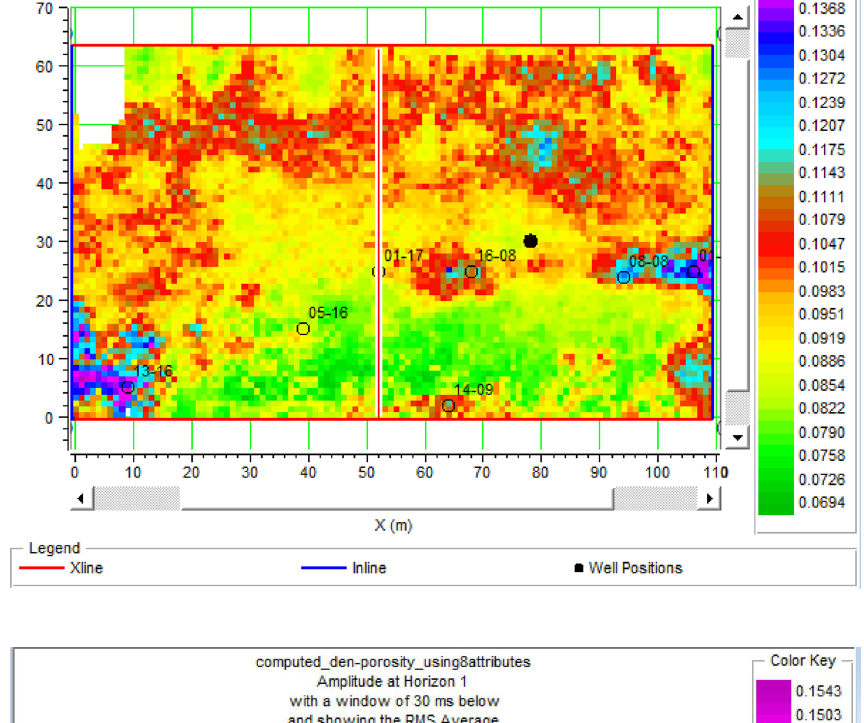
Fig. 39 2D porosity from multi-